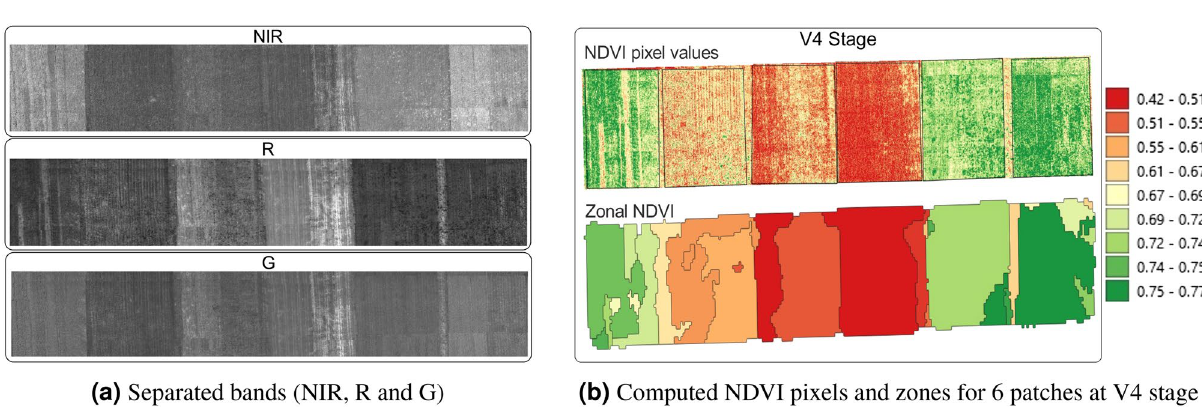
Figure 8. Band separation, and computed NDVI pixels and zonal